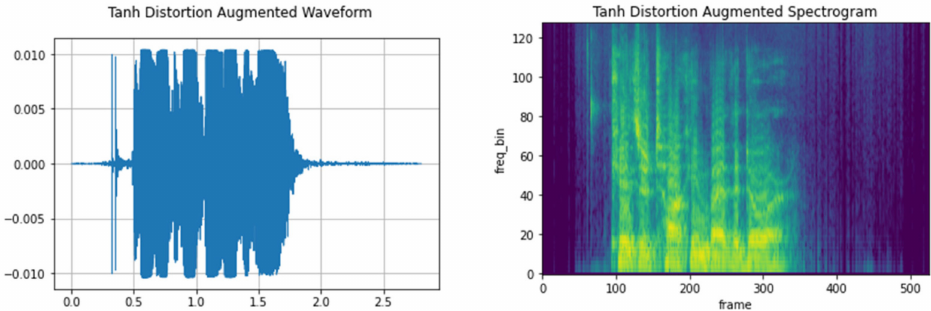
Figure 5. Waveform and Spectrogram representations of a Tan Distorted